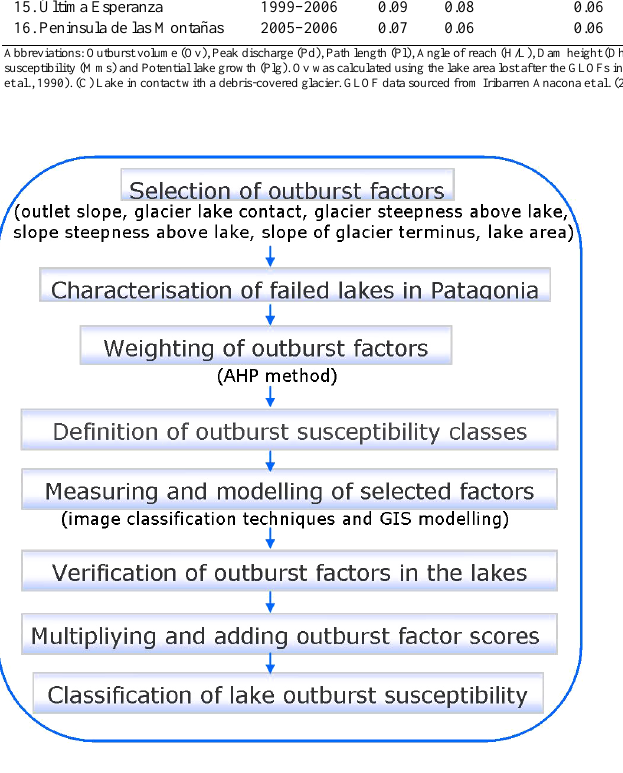
Figure 3. Flow chart of procedures followed to classify lake out- burst susceptibility in the Baker Basin.